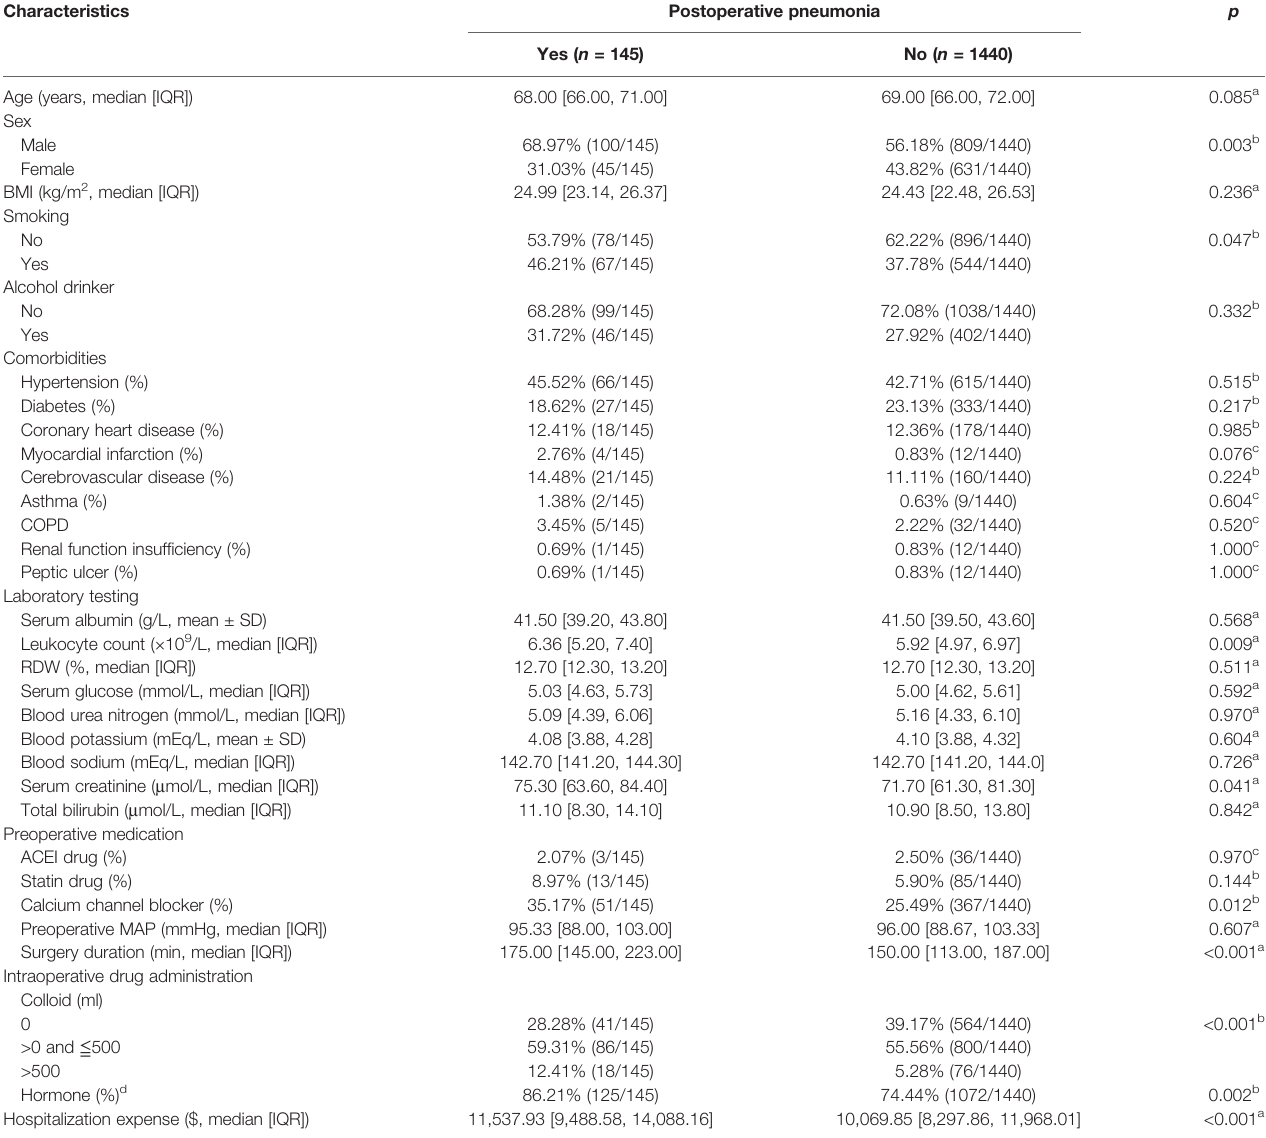
TABLE 1 | Patient ’ s basic and clinical demographics between patients with and without postoperative pneumonia.